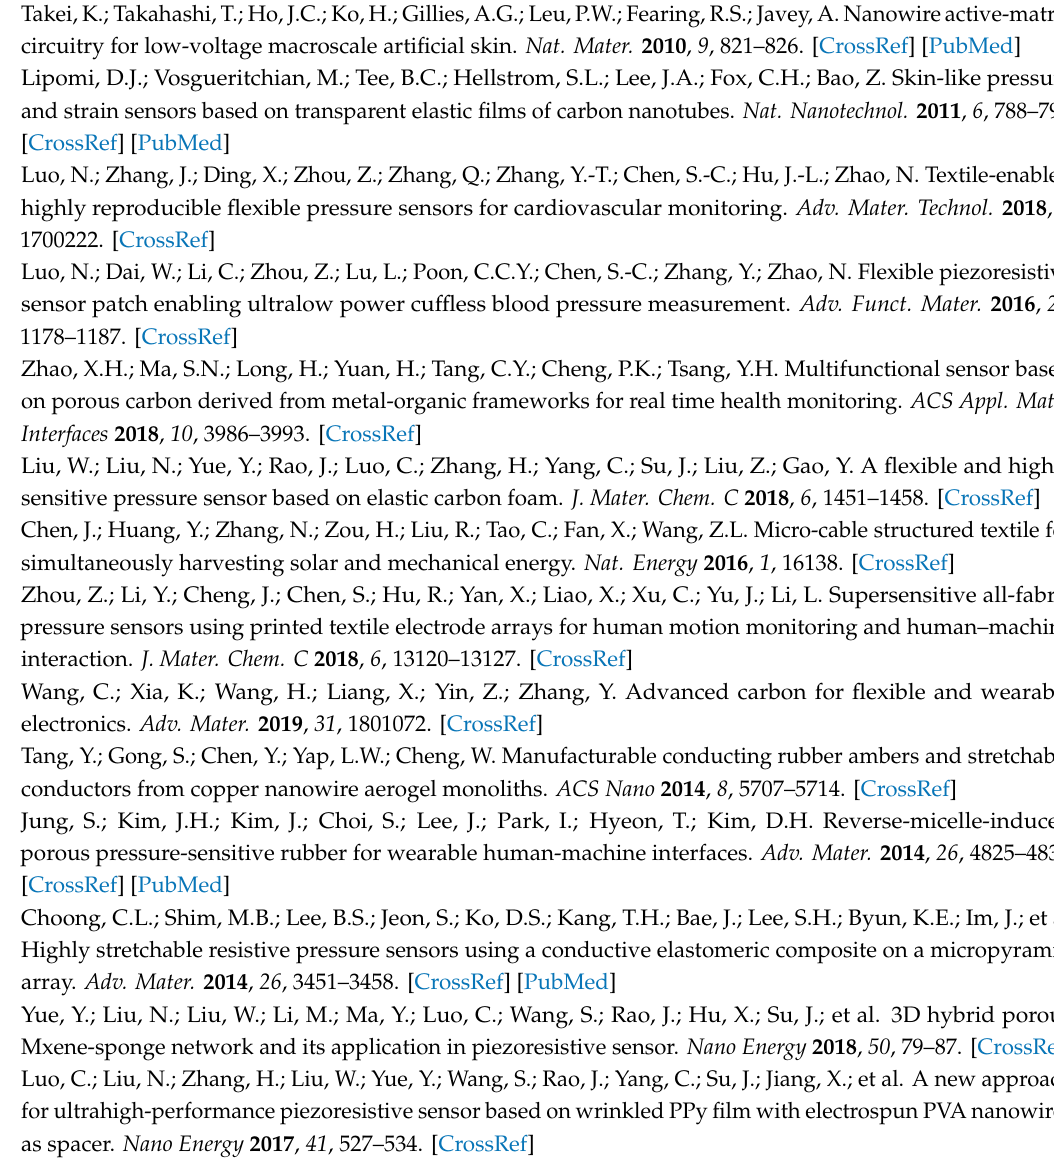
Figure S1. (a) Relative resistance change as a function of tensile strain. (b) Relative current change as a function of pressure change of 0 kPa-15 kPa-0 kPa, Figure S2. Relative change of the current under pressures of di ff erent sensors with or without NCB in the same batch, Figure S3. Arterial pulse waves under normal and after strenuous exercise